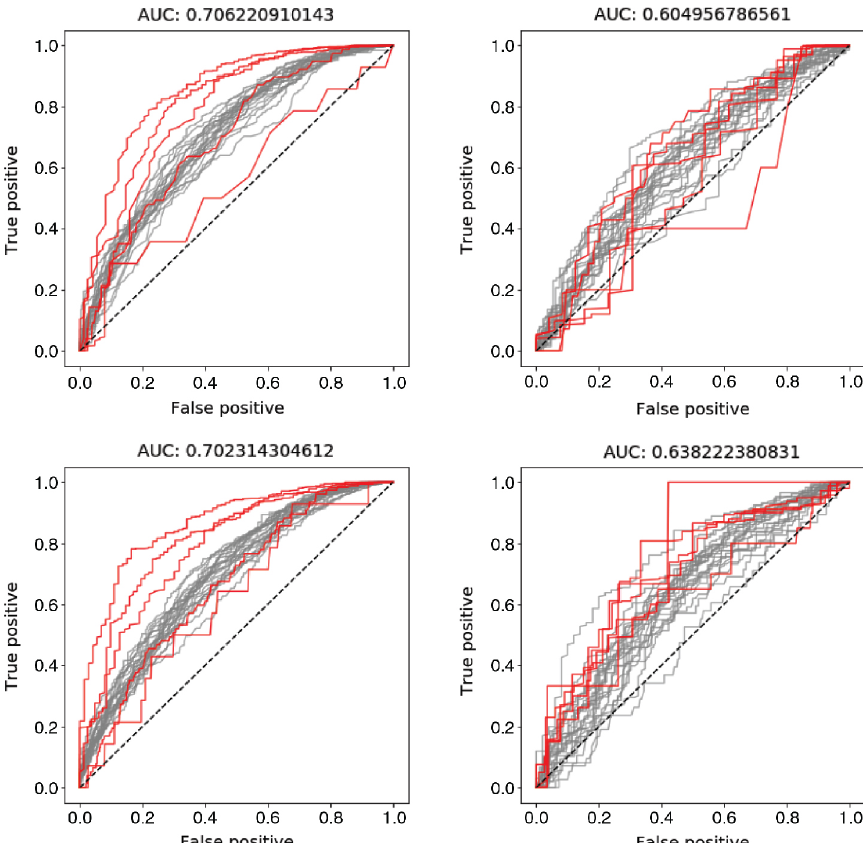
Figure 3: The ROC curves for each target variable from a model trained using the information described in experiment set-up 5 and set-up 6 for the SIDER dataset. The ROC curves for the five most unbalanced classes are highlighted in red, in order to show how the performance is affected by the weighting of the loss function. The top row shows results achieved using experiment set-up 5 and the bottom row results from experimental set-up 6. The left column shows the ROC curves for the training data and the right column for the test data. Note that the results for the test data are almost similar for the two set-ups while the performance for the test data increased in set-up 6. This is due to a better separation of the unbalanced classes, something that otherwise will bring down the mean AUC-ROC